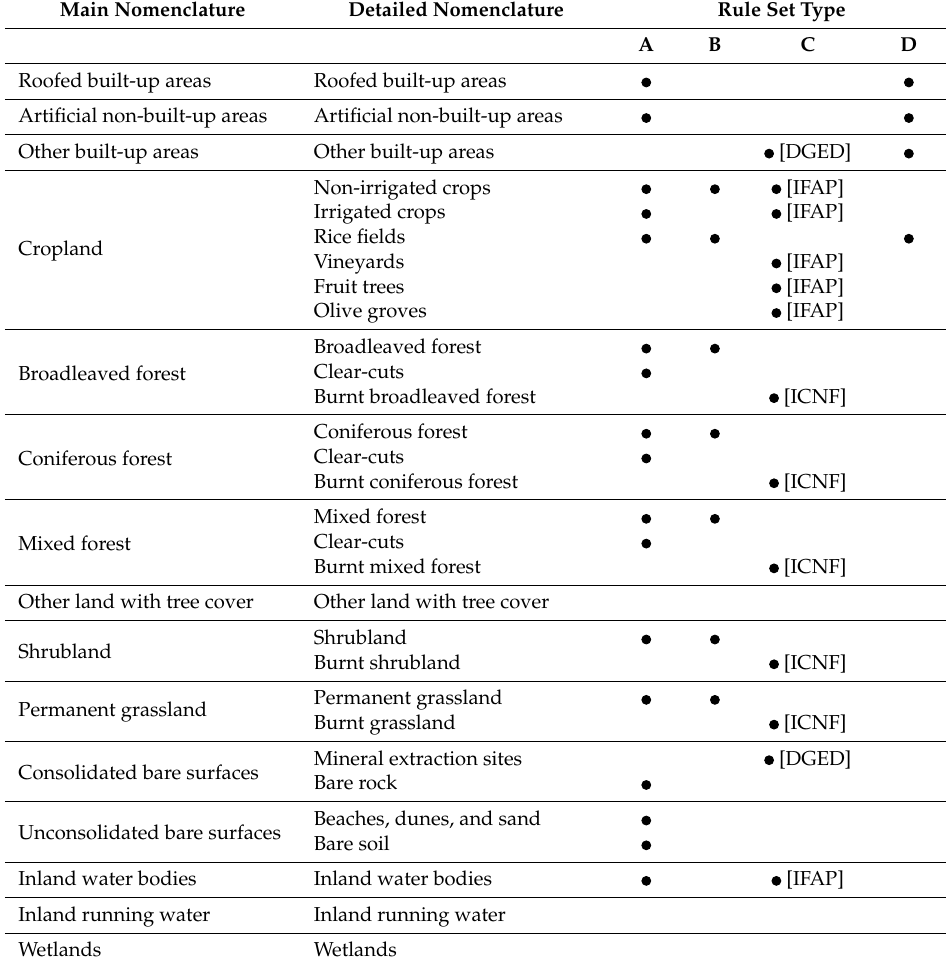
Table 6. Rule set types by which land cover classes were mapped (black circle indicates use). The source of the auxiliary data used in rules of type C is identified in square brackets. The rule set types are described in Table